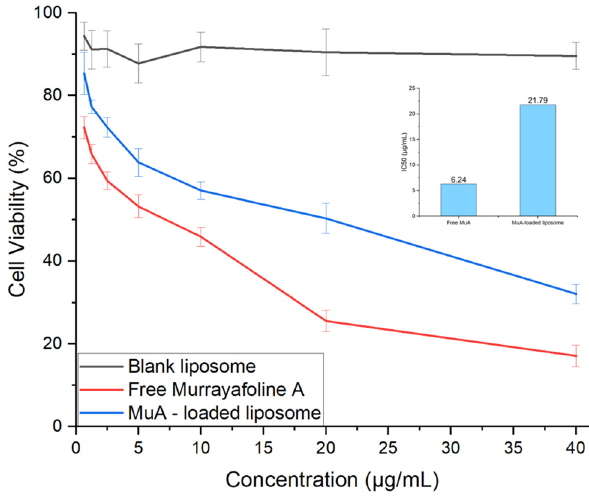
Figure 4: Cytotoxicity of free MuA, blank liposomes, and dialyzed MuA - loaded liposomes against HepG2